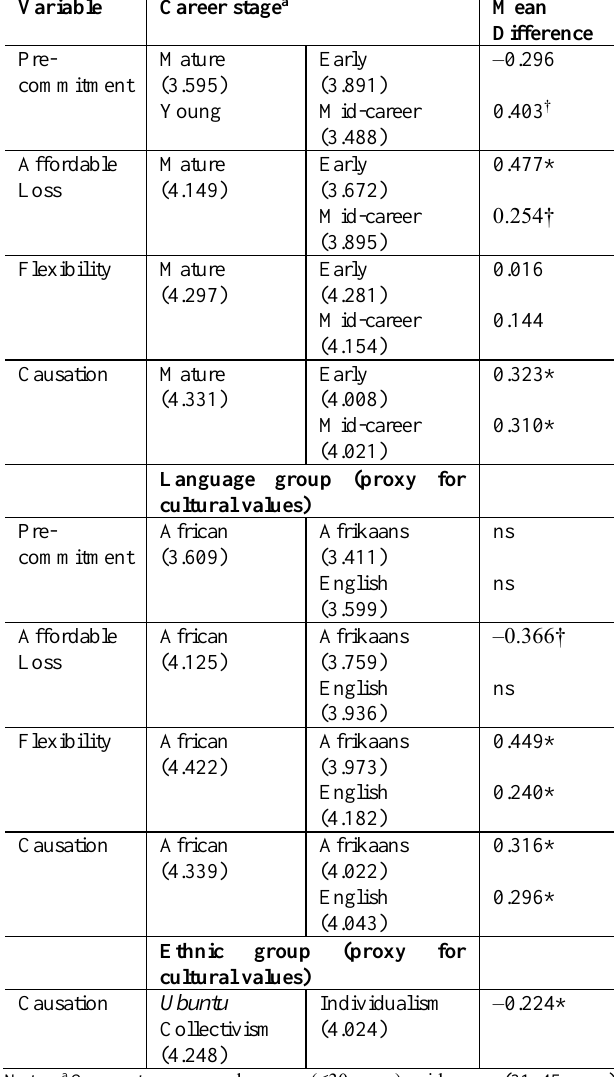
Table 5: Mean comparisons of career stages and